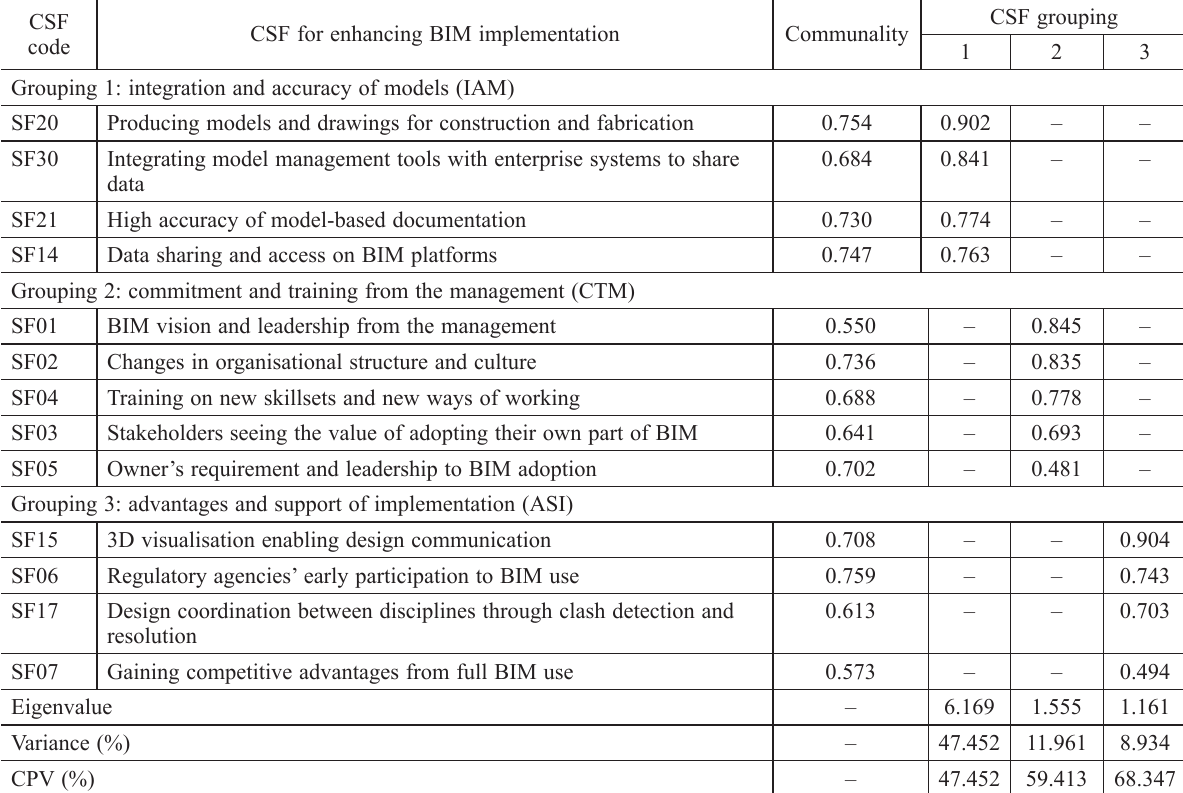
Table 4. Results of the EFA on CSFs to enhance BIM implementation CSF code